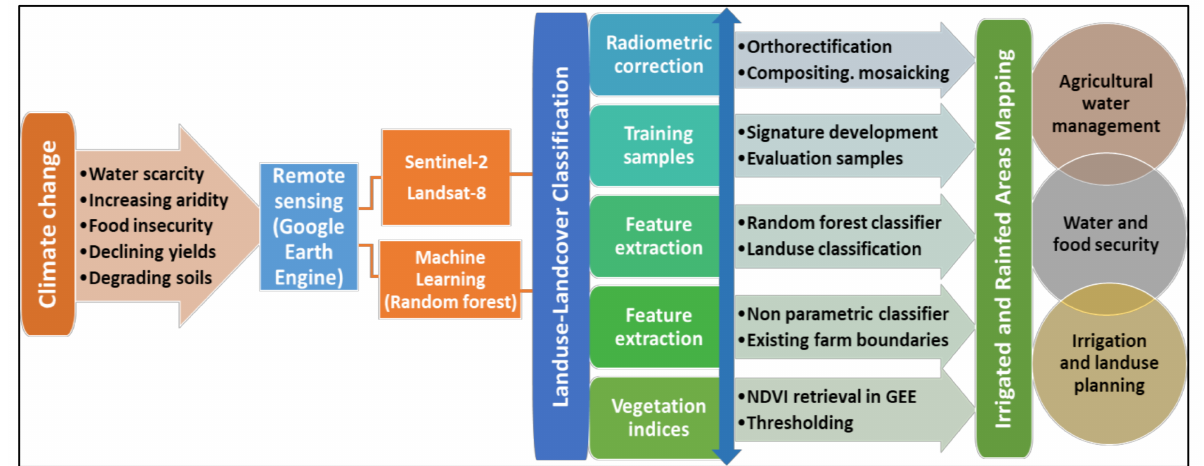
Figure 3. Methodological framework to classify irrigated areas using a non-parametric machine learning algorithm, random